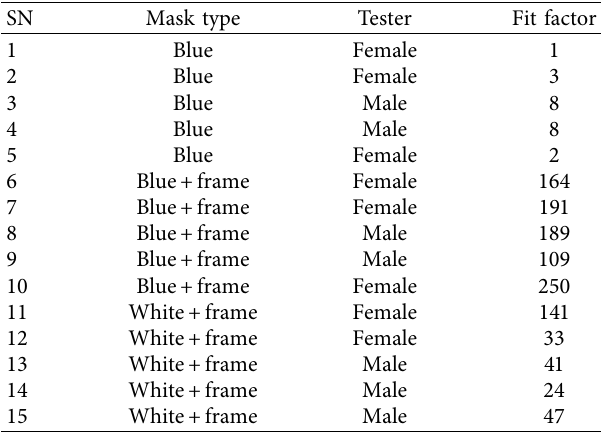
Table 2: Quantitative fit factors by testers and types of masks and